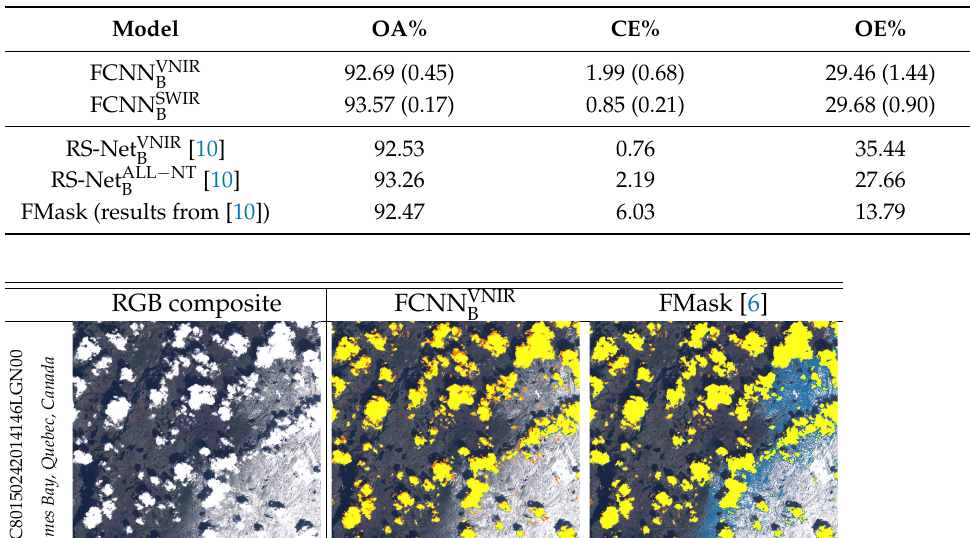
Table 4. Results of FCNN B (with and without SWIR bands), RS-Net (VNIR and ALL configurations), and FMask evaluated on the L8-SPARCS dataset.